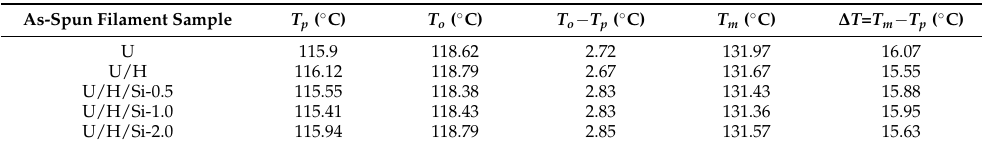
Table 2. Thermal property characteristics of U, U/H, U/H/Si-0.5, U/H/Si-1.0, and U/H/Si-2.0 as-spun filament